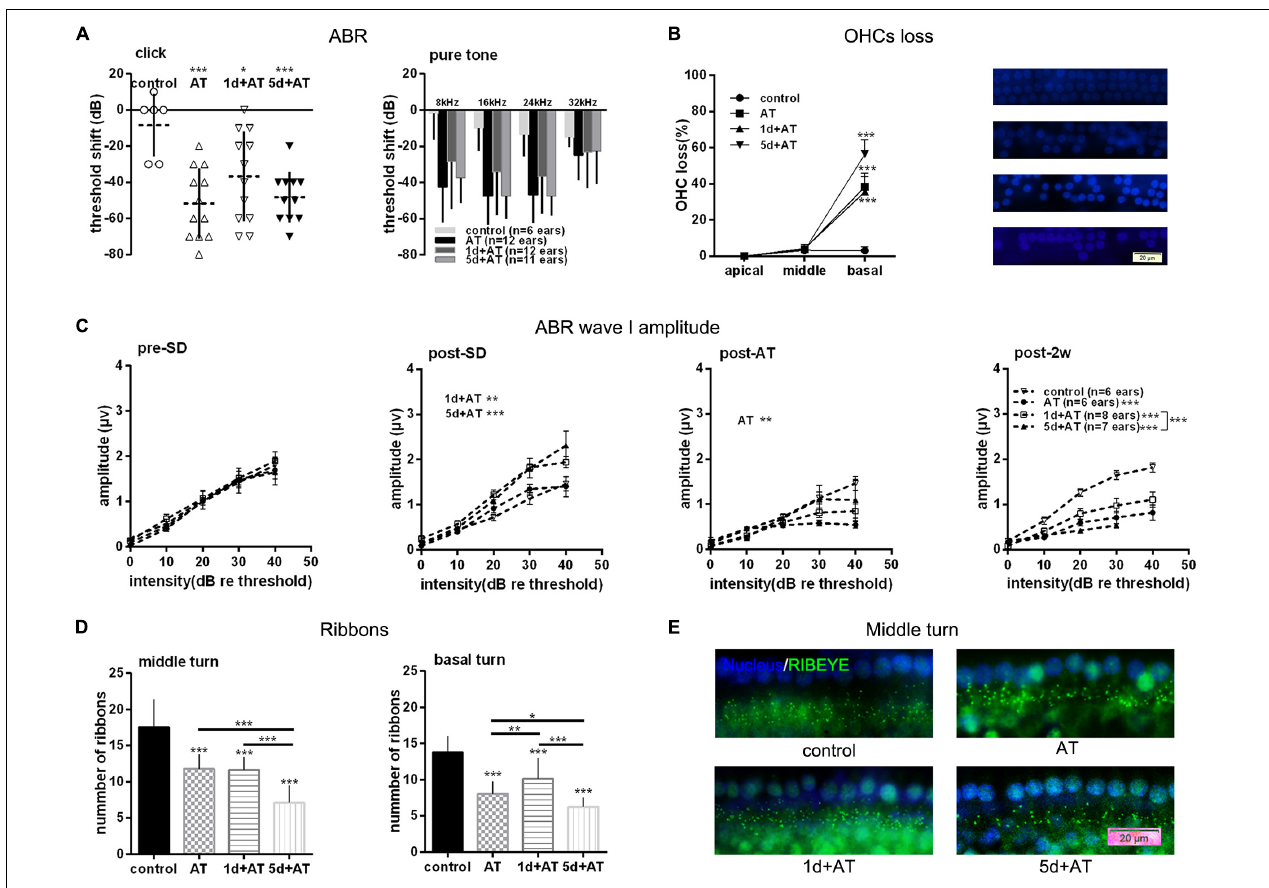
FIGURE 3 | Audiometric threshold shifts, and quantification of OHCs and IHC ribbons at post-2w, and ABR wave I amplitude for noise exposed groups and the control group. (A) Mean (transverse line) ± S.D. and individual ear audiometric threshold shift (dB) from baseline (pre-SD) determined from click and pure tone evoked ABRs for noise exposed groups and control group. The threshold shift was statistically significantly different between noise exposed groups and control group (click: one-way ANOVA, F = 7.256, P = 0.001; pure tone: two-way ANOVA, F = 18.433, P = 0.000 for effects of AT). Among the three noise exposed groups, the threshold shift measured by tone burst was significantly different (two-way ANOVA, F = 3.890, P = 0.023 for effects of SD; AT group and 1d + AT group: P = 0.029; AT group and 5d + AT group: P = 1.000; 1d + AT group and 5d + AT group: P = 0.113, Table 2 ), but not statistically different for click stimulus (one-way ANOVA, F = 1.812, P = 0.18). (B) Mean ± S.D. OHCs loss percentage in the basal, middle and apical cochlear turns, and fluorescence immunohistochemistry of OHCs nucleus (blue) in the basal turn for all noise exposed groups and control group. Significant differences were observed between noise exposed groups and control group (one-way ANONA, F = 34.995, P = 0.000 for effects of AT). No significant difference was observed between AT group and 1d + AT group ( post hoc Student’s t -test, P = 1.000) or 5d + AT group ( post hoc Student’s t -test, P = 0.053). Significant difference was observed between the 1d + AT group and the 5d + AT group ( post hoc Student’s t -test, P = 0.008). (C) Mean ± S.E.M. ABR wave I amplitude growth function for noise exposed groups and the control group. The baselines (pre-SD) of wave I amplitudes were not statistically different (two-way ANOVA, F = 0.089, P = 0.500 for effects of AT), and wave I amplitudes increased after SD (post-SD) (two-way ANOVA, F = 11.636, P = 0.000, control vs. 1d + AT group: two-way ANOVA, P = 0.001, control vs. 5d + AT group: two-way ANOVA, P = 0.000), but reduced immediately after noise exposure (two-way ANOVA, F = 3.388, P = 0.021, control vs. AT group: two-way ANOVA, P = 0.013). After 2 weeks, significant reduction in wave I amplitudes were observed for all AT groups (two-way ANOVA, F = 29.315, P = 0.000), and significantly differences were also observed in wave I amplitudes between 1d + AT group and 5d + AT group (two-way ANOVA, P = 0.000, also see Table 2 ). (D) Mean ± S.D. IHC ribbons in the basal turn and middle cochlear turn for all the AT groups at post-2w. The ribbon numbers were statistically significant different between noise exposed groups and control group for the basal turn (one-way ANONA, F = 69.008, P = 0.000) and middle turn (one-way ANONA, F = 76.274, P = 0.000). For all noise exposed groups, significant differences were observed in the basal turn between 1d + AT group and 5d + AT group ( post hoc Student’s t -test, P = 0.000), between AT group and 1d + AT group ( post hoc Student’s t -test, P = 0.001), or 5d + AT group ( post hoc Student’s t -test, P = 0.032). Significant differences were also detected in the middle turn between 1d + AT group and 5d + AT group ( post hoc Student’s t -test, P = 0.000), and between AT group and 5d + AT group ( post hoc Student’s t -test, P = 0.000). (E) Fluorescence immunohistochemistry of ribbons in cochlear middle turn.